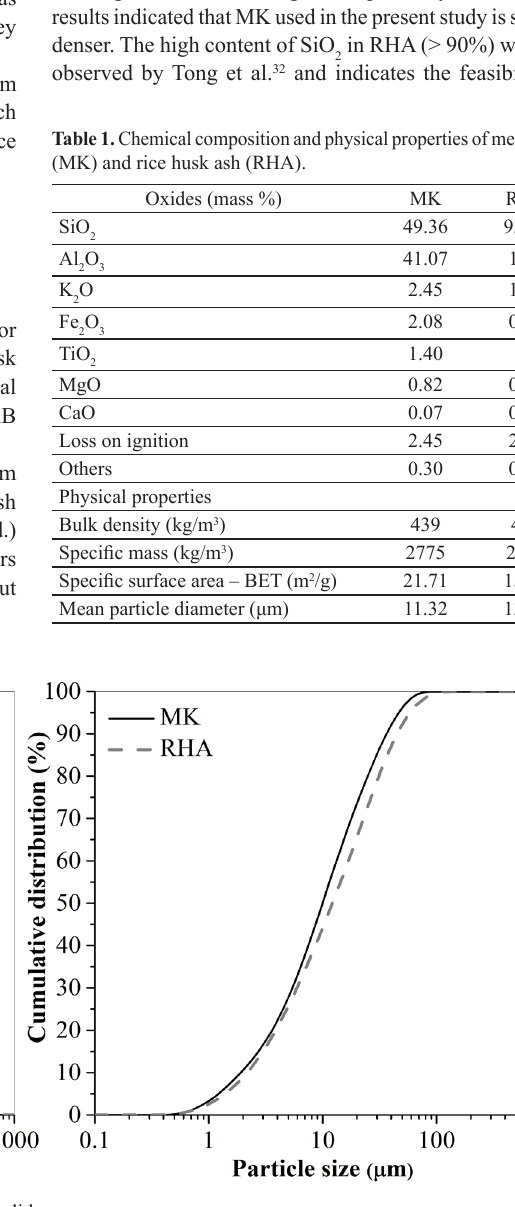
Figure 1. Frequency (a) and cumulative (b) distribution of the solid